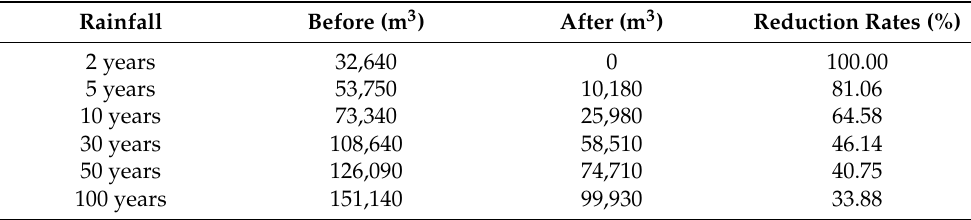
Note: Rainfall is indicated with varying return periods; reduction rates refer to outflow